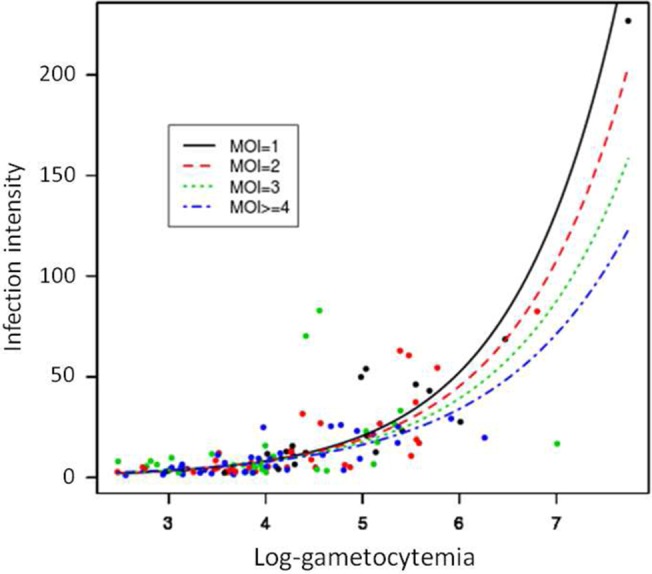
A, fitted intensity of infection curve versus log-transformed of gametocytemia for the different MOIs in the HNB2 model.The analysis was performed from 125 feedings.